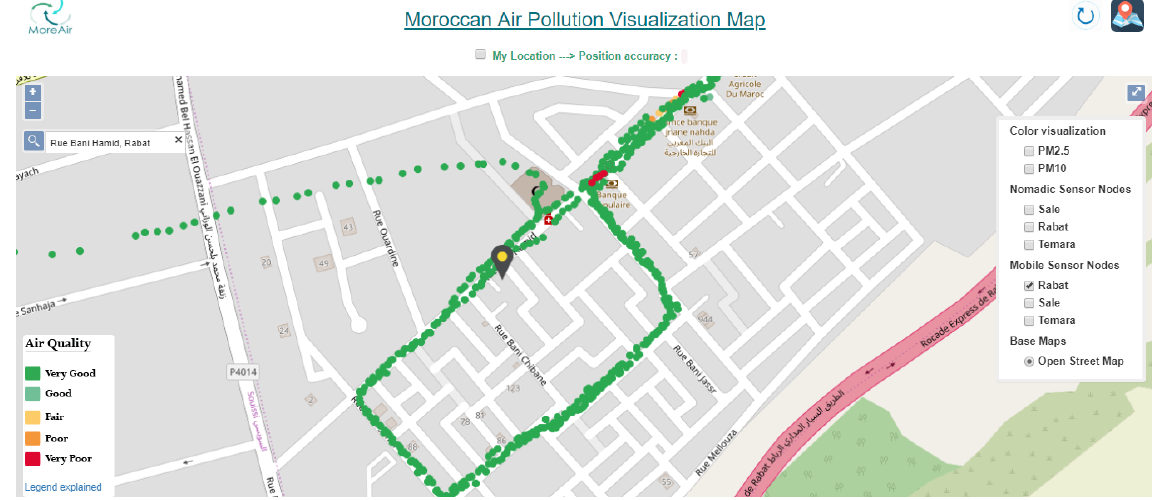
Figure 16. Mobile sensor nodes visualization in a neighborhood in Rabat.